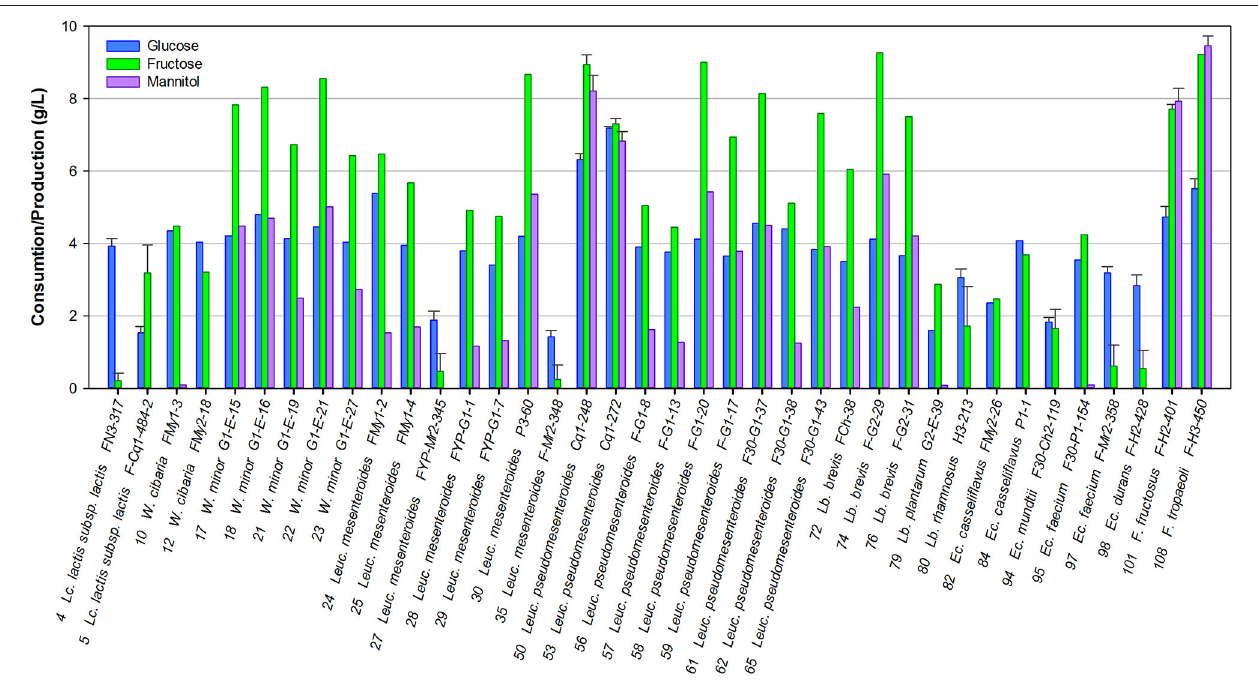
FIGURE 2 | Consumption of sugars and mannitol production by selected LAB grown in FSM at 30 ◦ C for 24